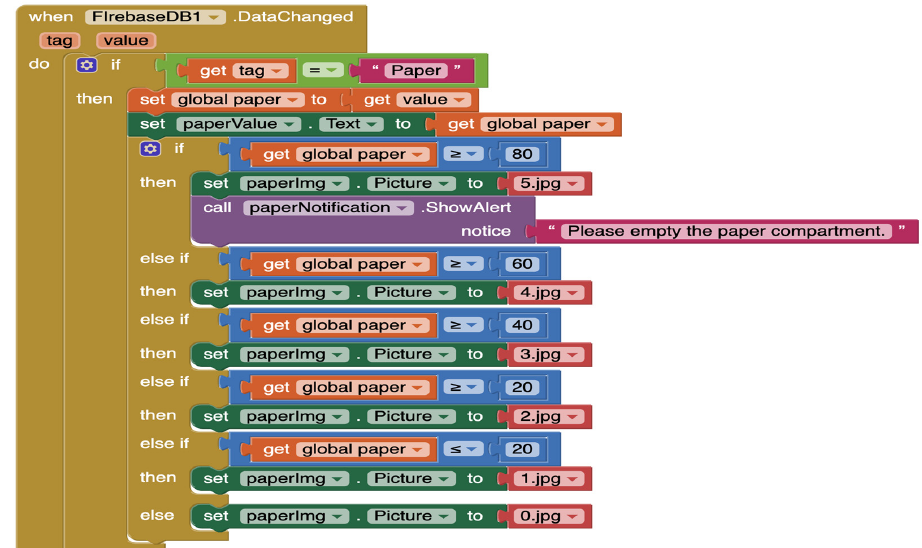
Figure 11. Puzzle code for mobile application in MIT App Inventor.